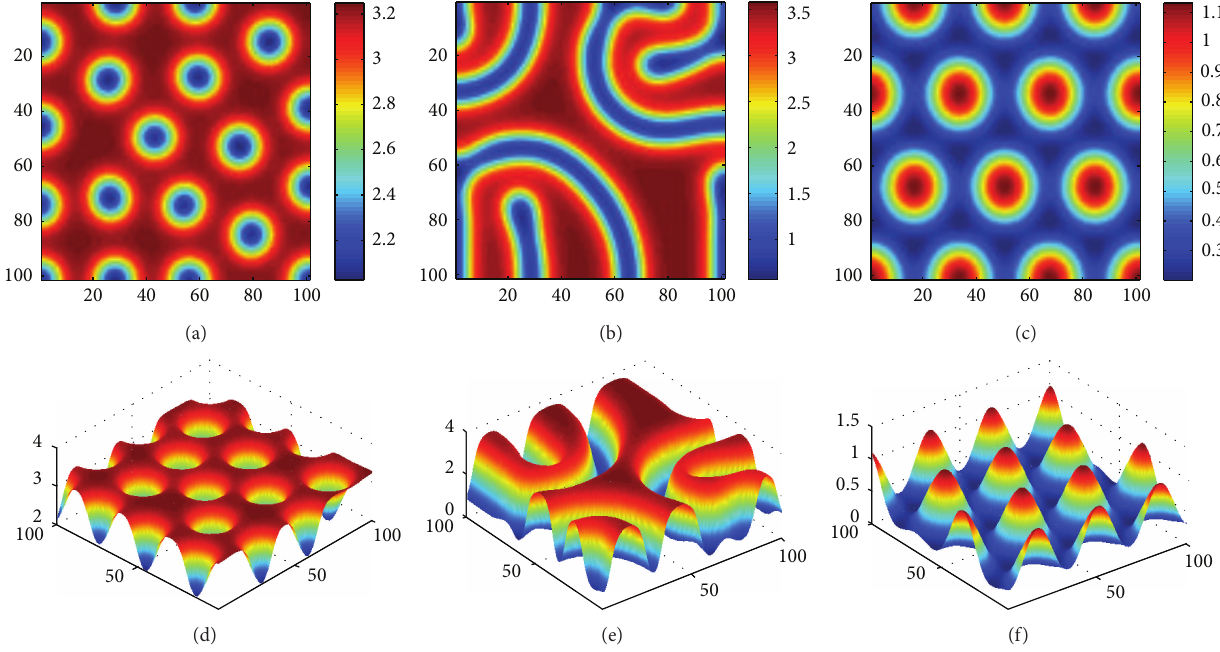
, 𝑑 ) = (0.4, 0.89, 0.37) , and (c) (f) (𝑑,𝑑 21 22